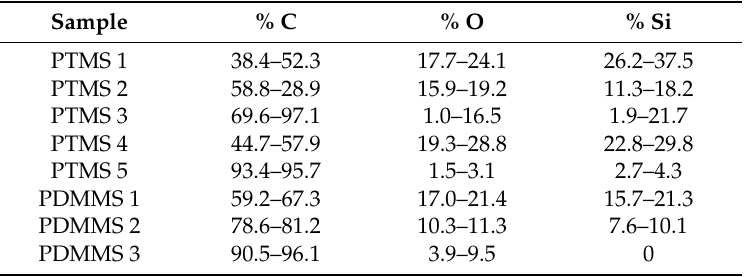
Table 3. Elemental composition for each propyltrimethoxysilane (PTMS) and propyldimethylmethoxysilane (PDMMS) sample found by